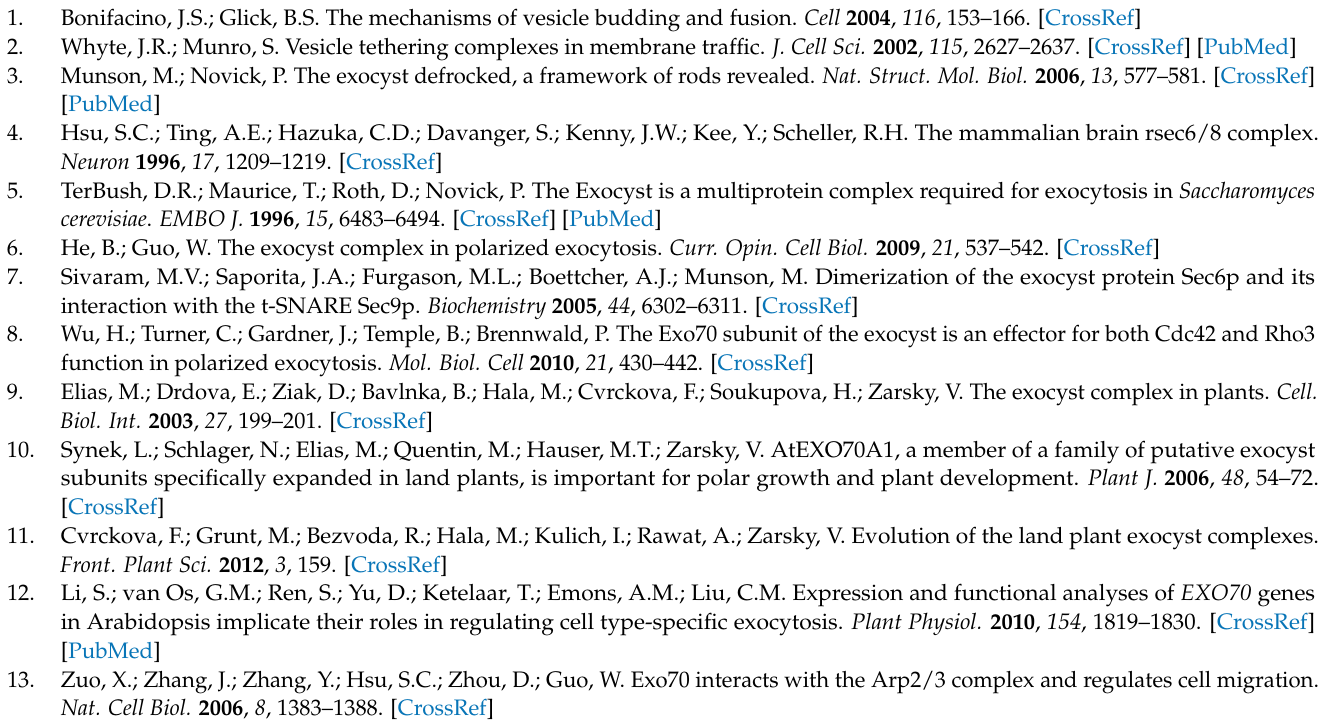
rice. Figure S4. EXO70 family gene expression patterns in different tissues and organs of asian cotton. Figure S5. Cis-acting elements in Arabidopsis EXO70s promoter. Figure S6. Cis-acting elements